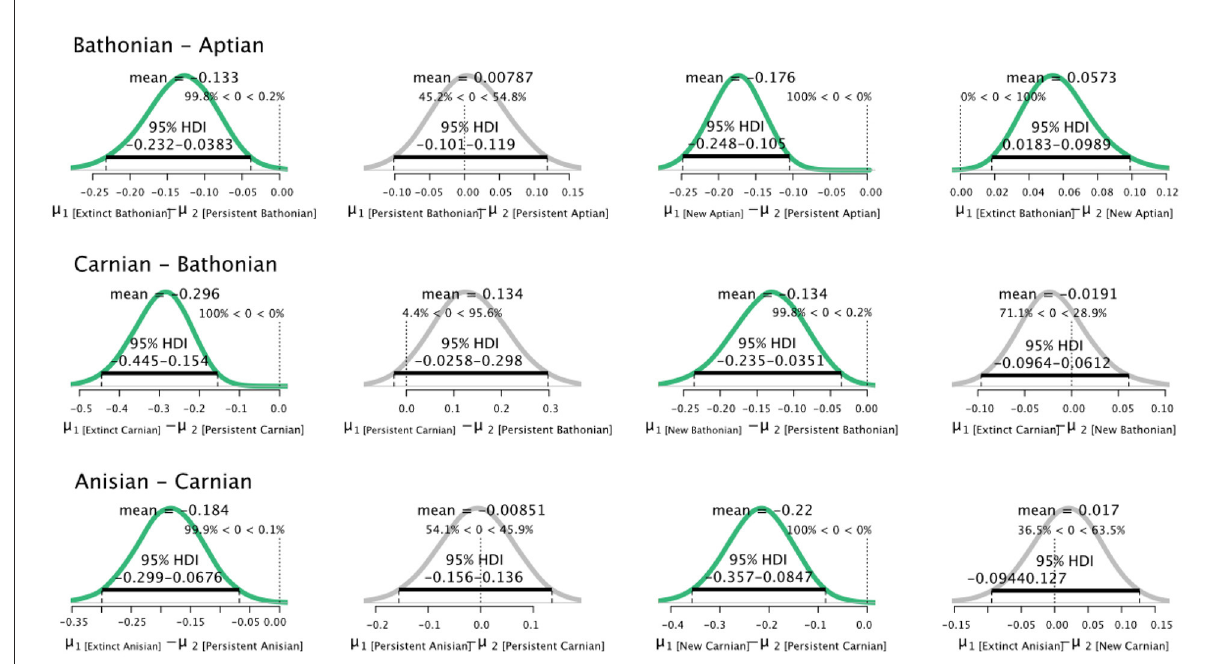
FIGURE4 Differences in posterior distributions of percent guild richness for guilds that went extinct, persisted, or were new between pairs of communities. Bathonian–Aptian (top) , Carnian–Bathonian (middle) , Anisian–Carnian (bottom) . The mean is shown for each resulting distribution, as is the 95% High Density Interval (black bar). Finally, the percentage of data that falls below and above zero is shown on the small vertical dotted